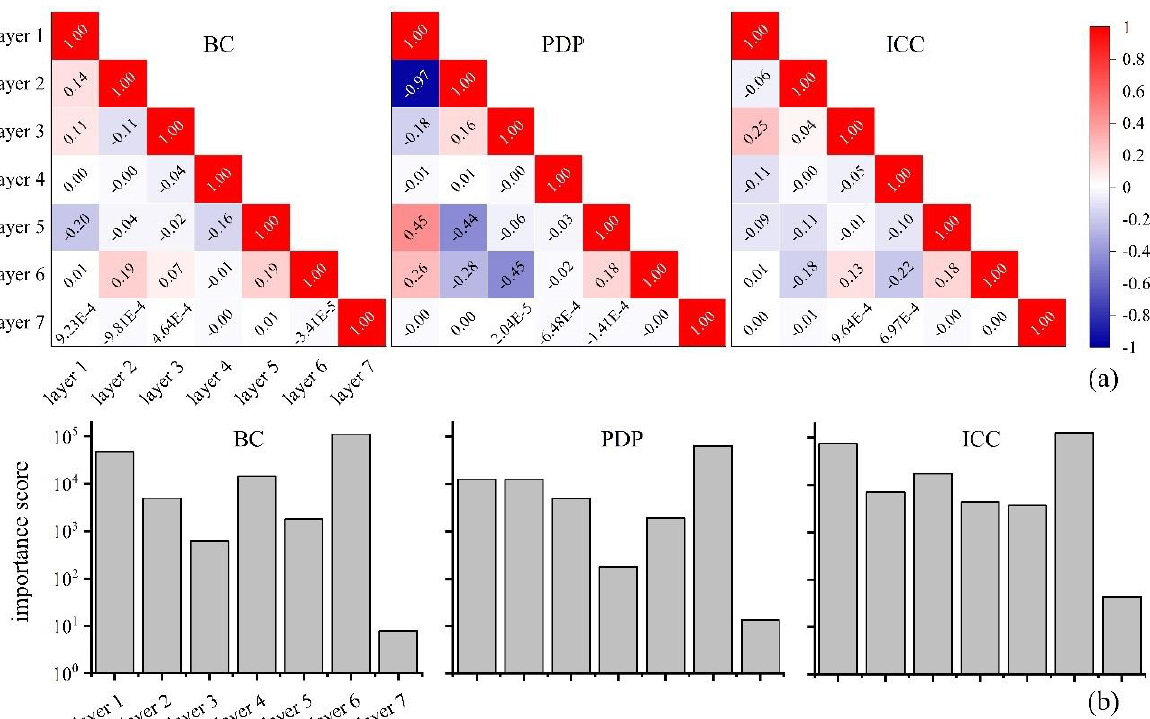
Figure 12. ( a ) The correlation coefficient between any two layers in the BC, PDP, and ICC data suites. ( b ) The importance ranking of the seven layers in each of the BC, PDP, and ICC suites. The x-axis is the layers of each data suite (see Table 2), and the y-axis is the chi-square statistic value of the Kruskal – Wallis test, which represents the importance of the layer in the recognition of the surface type of the glacial area.